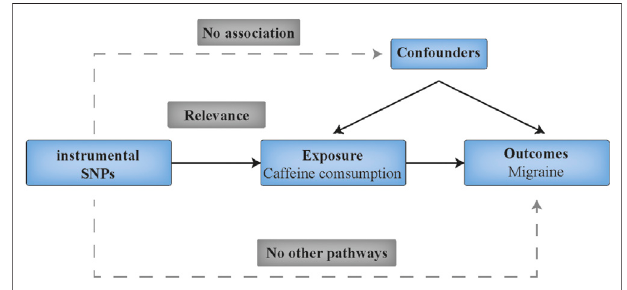
FIGURE 1 | Schematic diagram showing the assumptions of Mendelian randomization analysis. SNPs indicates single nucleotide polymorphisms.